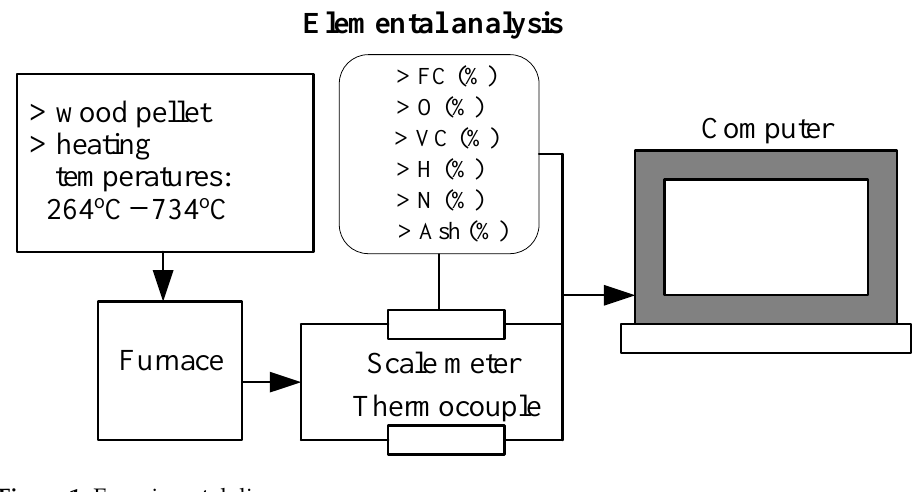
Figure 1. Experimental diagram.